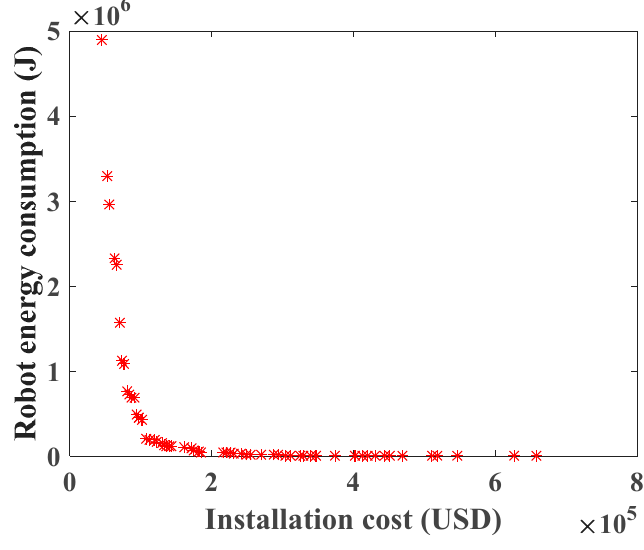
Sensors 2020 , 20 , x FOR PEER REVIEW Figure 11. Pareto front with 300 towers. Figure 11. Pareto front with 300 towers.